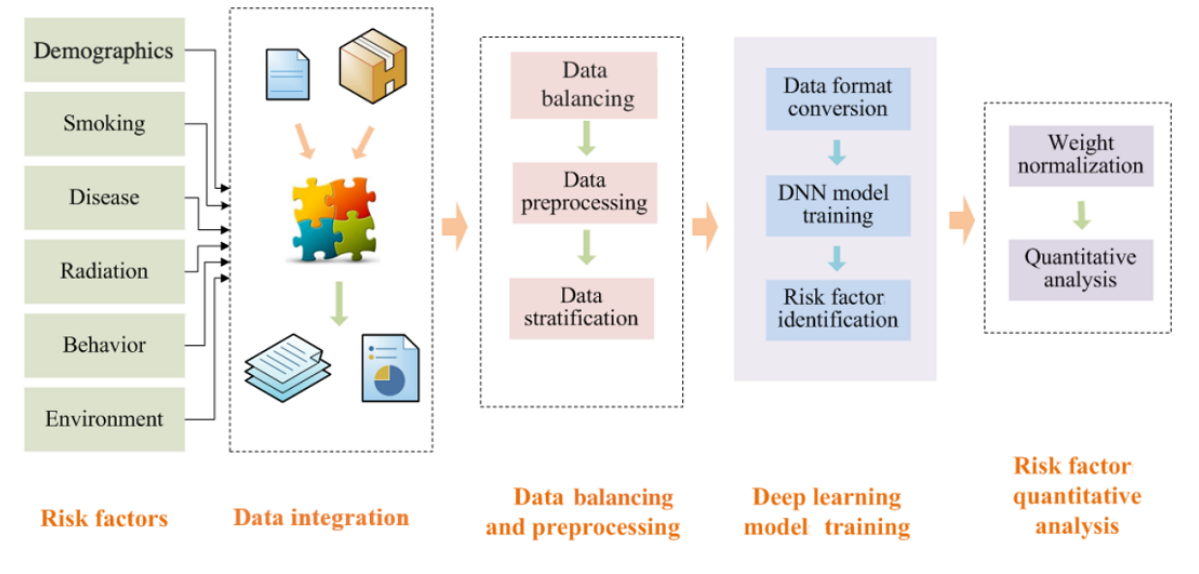
Figure 2. Schematic diagram of lung cancer risk factor identification in the elderly. DNN: deep neural